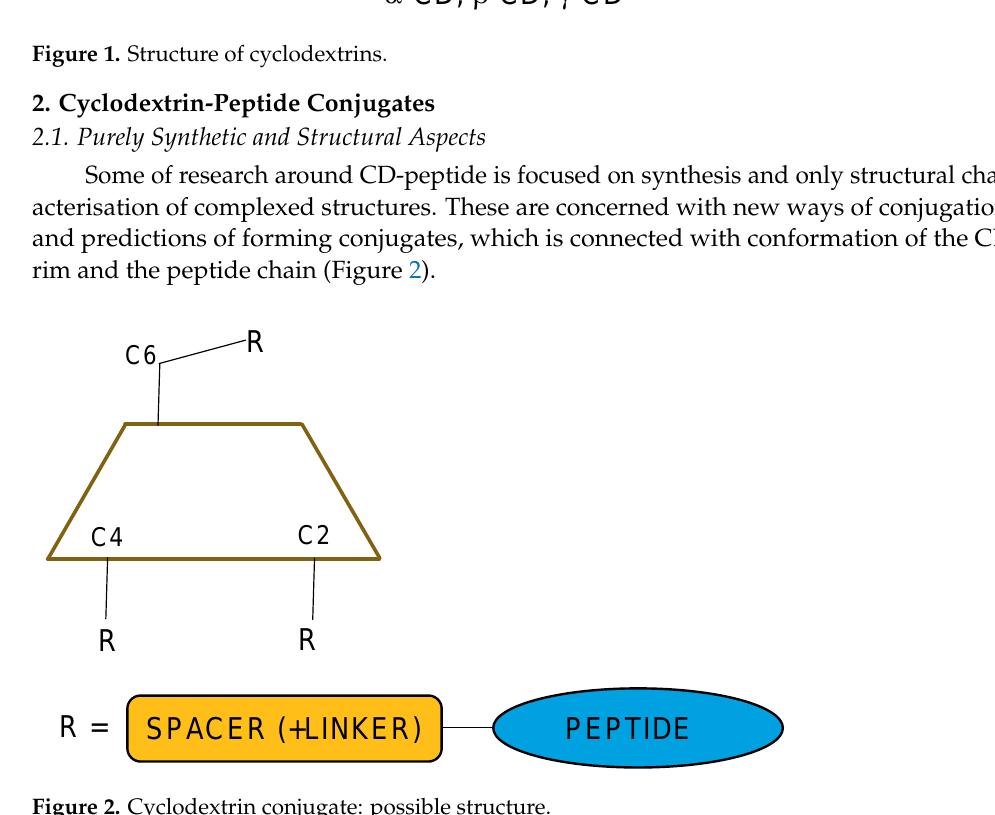
Figure 1. Structure of cyclodextrins.